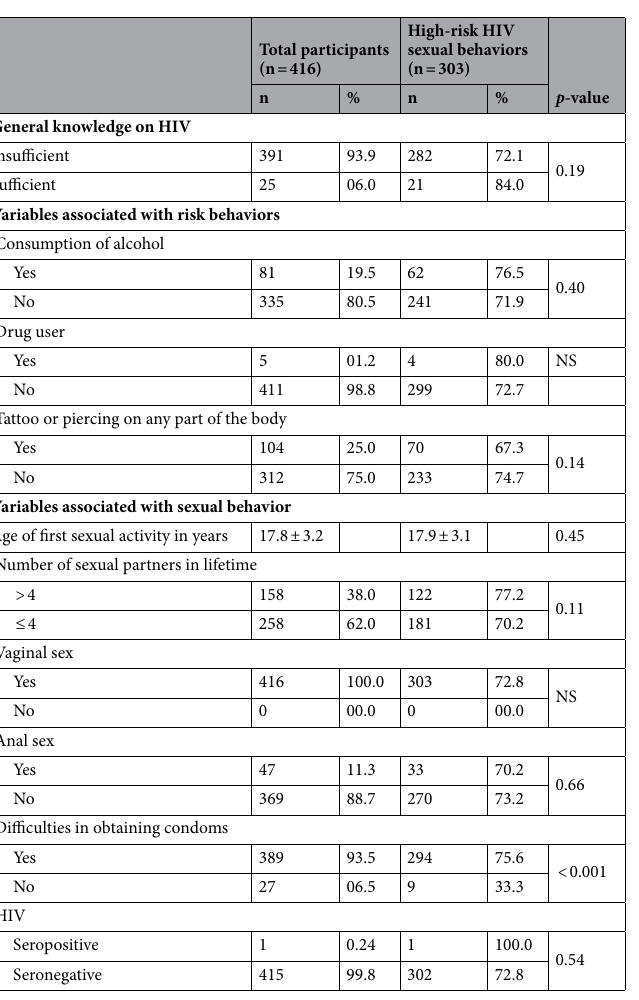
Table 2. Knowledge, risk behaviors and sexual HIV behaviors among sexually active migrants, Morocco, 2021. sd standard deviation. For qualitative variables, the Pearson chi-2 test estimated the association between the dependent variable and the independent variables when the conditions were valid. For the quantitative variables, we used a comparison test of two means; p -value was considered significant when it was less than